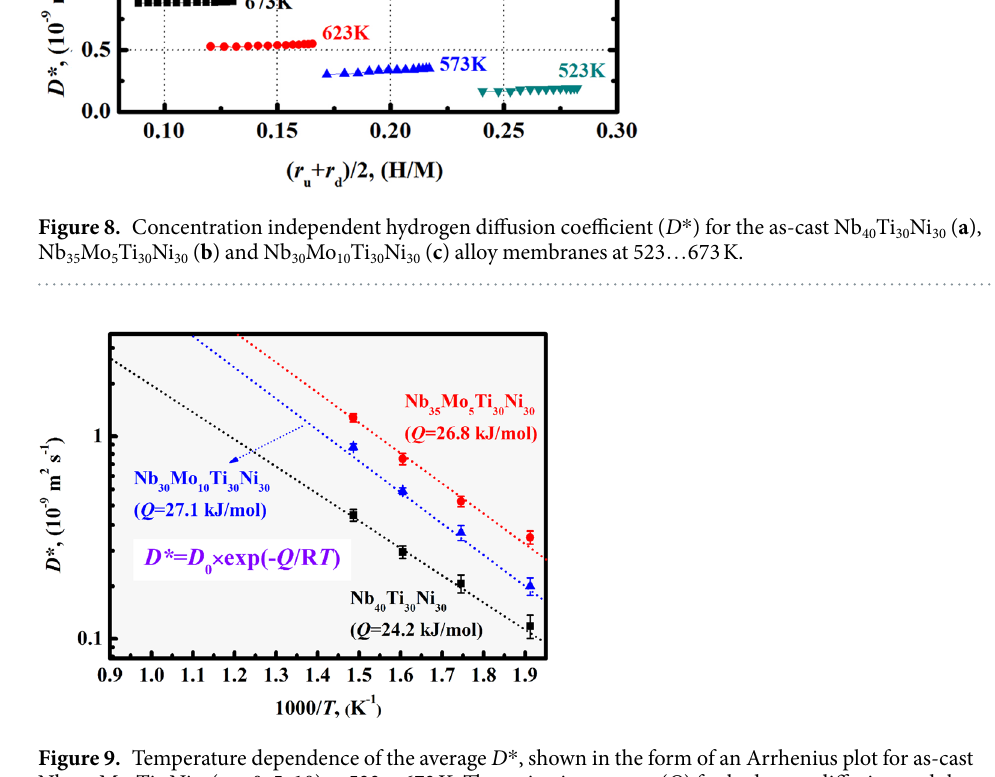
follows a linear temperature dependence in the Arrhenius plot, as shown in Fig. 9. The activation energy ( Q ) of hydrogen diffusion for a dilute hydrogen concentration, and the diffusion pre-exponential factor ( D 0 ) can be determined. From Fig. 9 it is concluded that the addition of Mo in Nb increases the average D * , in a more pro- nounced manner for x = 5 than for x = 10. This particular change mainly originates from the difference in the D 0 values, since there is no significant difference in the Q values for the three alloys. D 0 can be expressed as ν = , where λ , Z, v , S B , S W and k are jump width, correlation number, jump frequency, entropy of vacancy formation, entropy of vacancy migration and Boltzmann’s constant, respectively. The substi- tution of Nb by Mo must induce diverse effects on the parameters in the expression of D 0 , such that the D 0 and